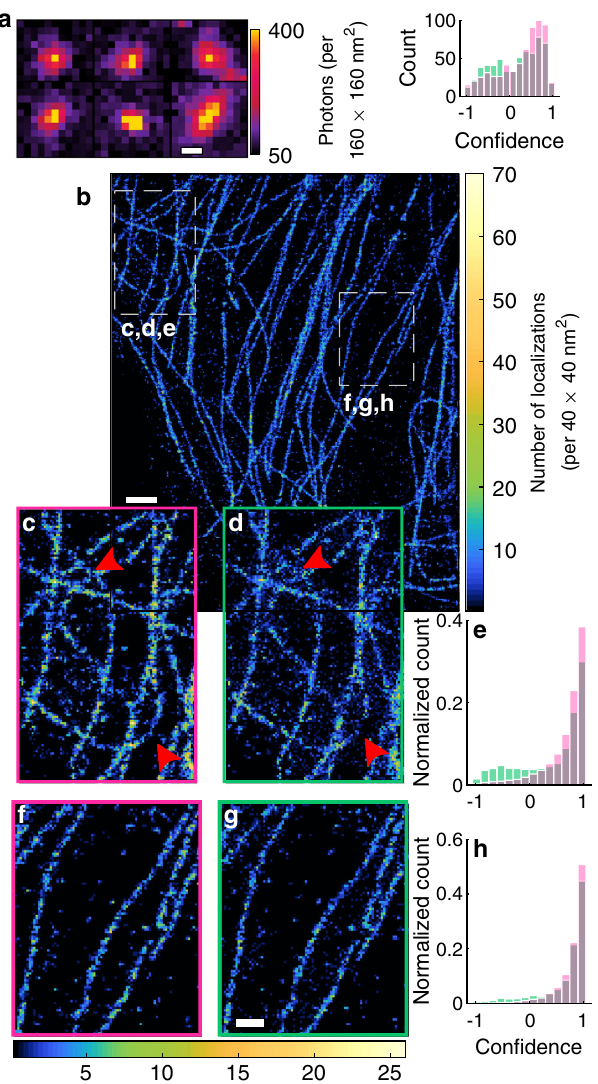
Fig. 2 Comparison of 2D SMLM algorithms on experimental images of Alexa Fluor 647-labeled microtubules. a Left: isolated images of Alexa Fluor 647 molecules. Right: localization con fi dences for 600 isolated molecules using RoSE (red) and TS (green). b SMLM image of microtubules recovered by RoSE. c , d Enlarged top-left region in ( b ) for RoSE and TS, respectively. e Histogram of con fi dences corresponding to localizations in ( c ) and ( d ) for RoSE (red) and TS (green), respectively. f , g Similar to ( c , d ) but for the middle-right region in ( b ). h Similar to ( e ) but for localizations in ( f ) and ( g ). Color bars: a photons detected per 160 × 160 nm 2 , b number of localizations per 40 × 40 nm 2 . Scale bars: a 500 nm, b 1 μ m, and g 500